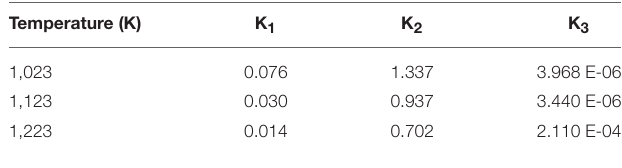
TABLE 3A | Model results: equilibrium constant values.